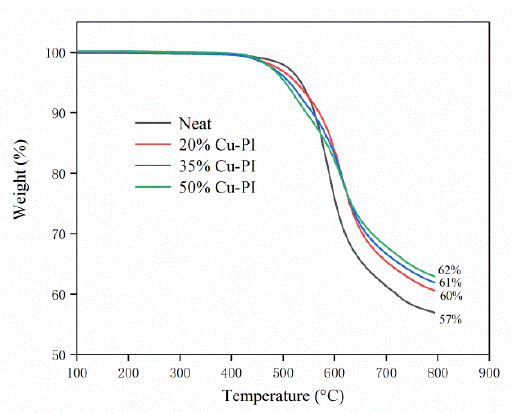
Figure 4. TGA curves of neat PI and Cu-PI films under a nitrogen atmosphere.